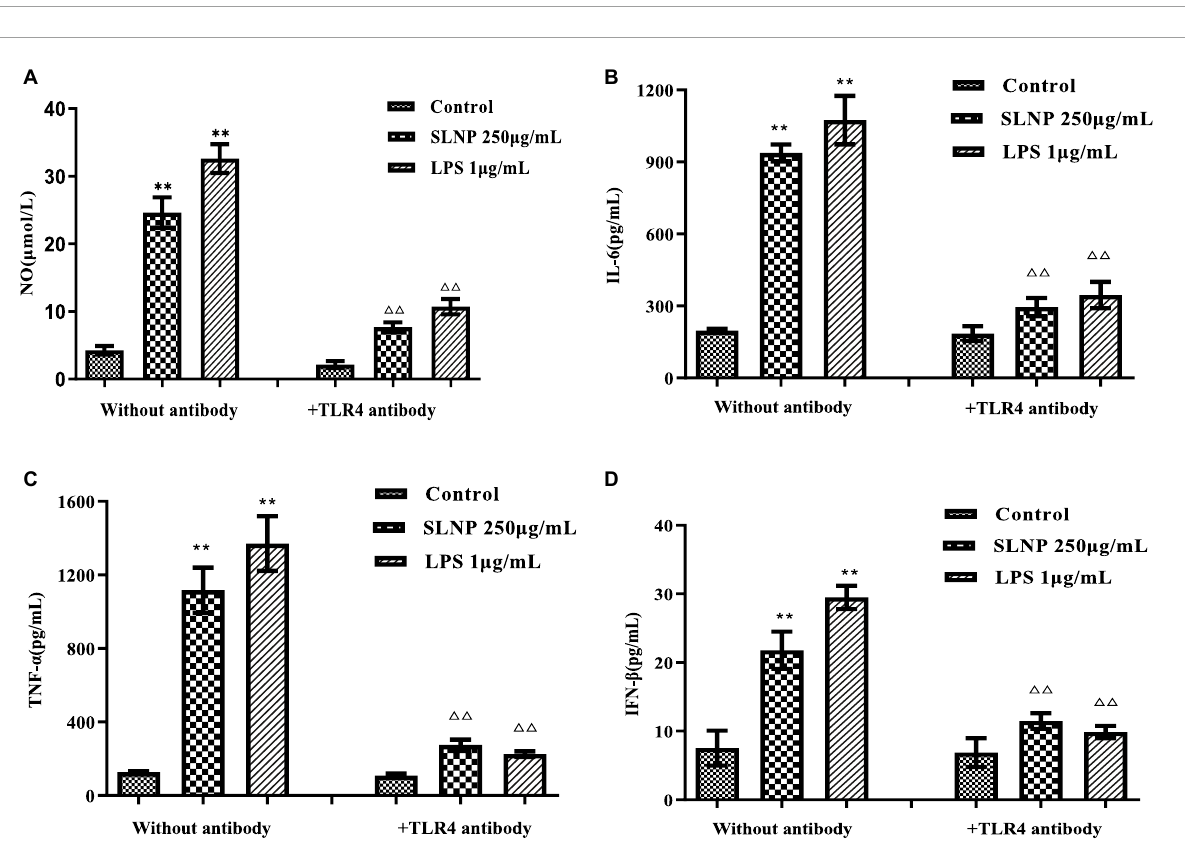
FIGURE10 Effects of TLR4 antibodies on NO (A) , IL-6 (B) , TNF- α (C) , and IFN- β (D) production in RAW264.7 macrophage induced by Sparassis latifolia neutral polysaccharides SLNP. Compared with blank control group, ∗ p < 0.05, ∗∗ p < 0.01; Compared with LPS control group, (cid:49) p < 0.05 , (cid:49)(cid:49) p <